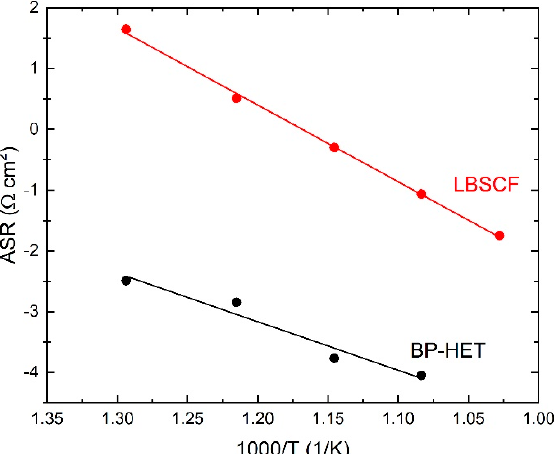
Figure 8. Area Specific resistance (ASR) for BP-HET (black line) and LBSCF (red